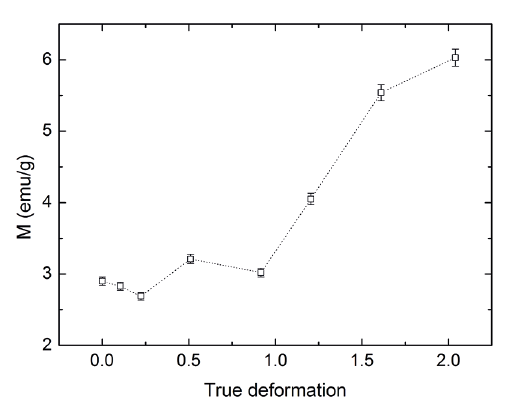
Figure 2. Saturation magnetization as function of true deformation. Table 4: Pitting potentials (E